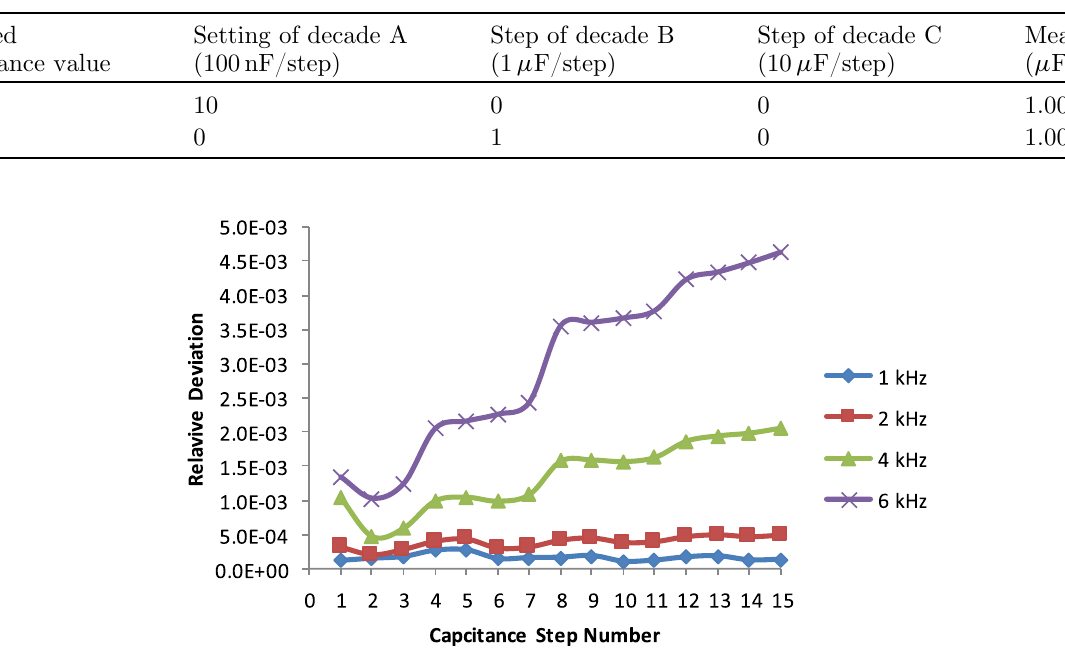
Fig. 6. Relative deviation of output capacitance steps at different frequencies and 1 V.